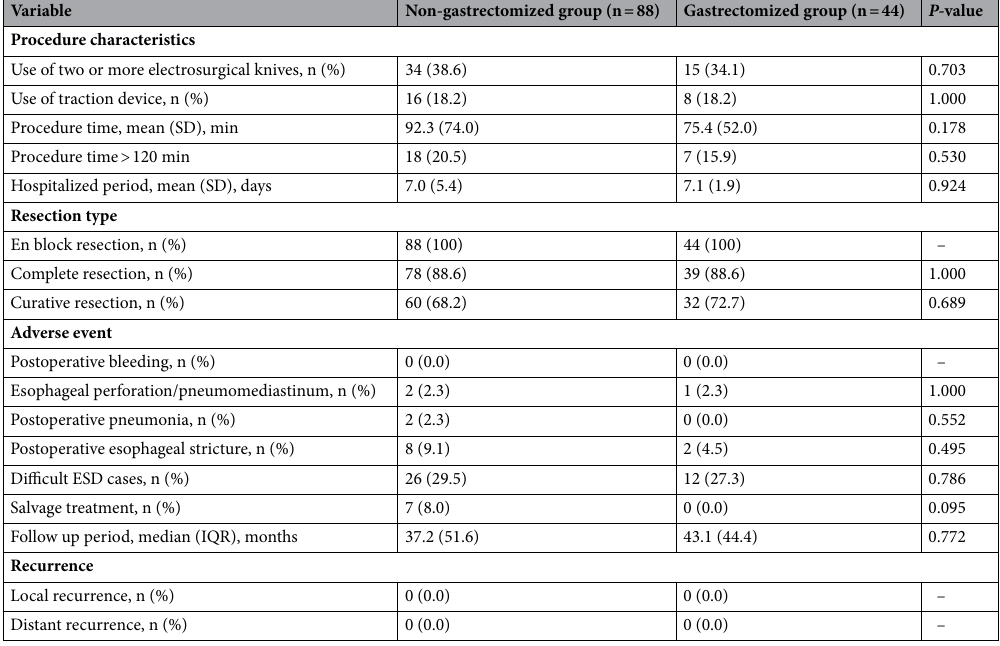
Table 3. ESD outcome comparisons between the non-gastrectomized and gastrectomized groups after propensity-score matching. ESD Endoscopic submucosal dissection, SD Standard deviation, IQR Interquartile